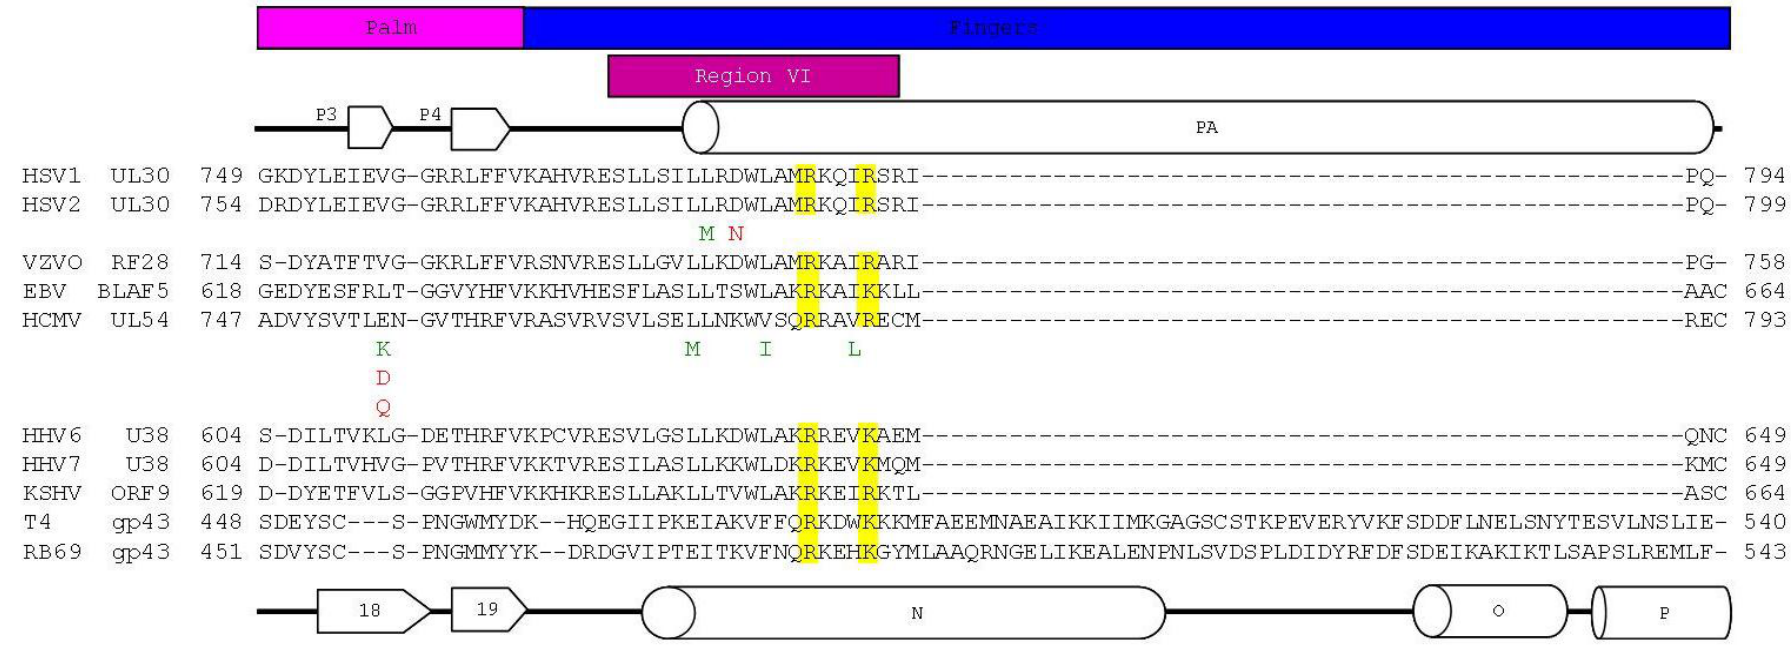
Appendix Figure A1.